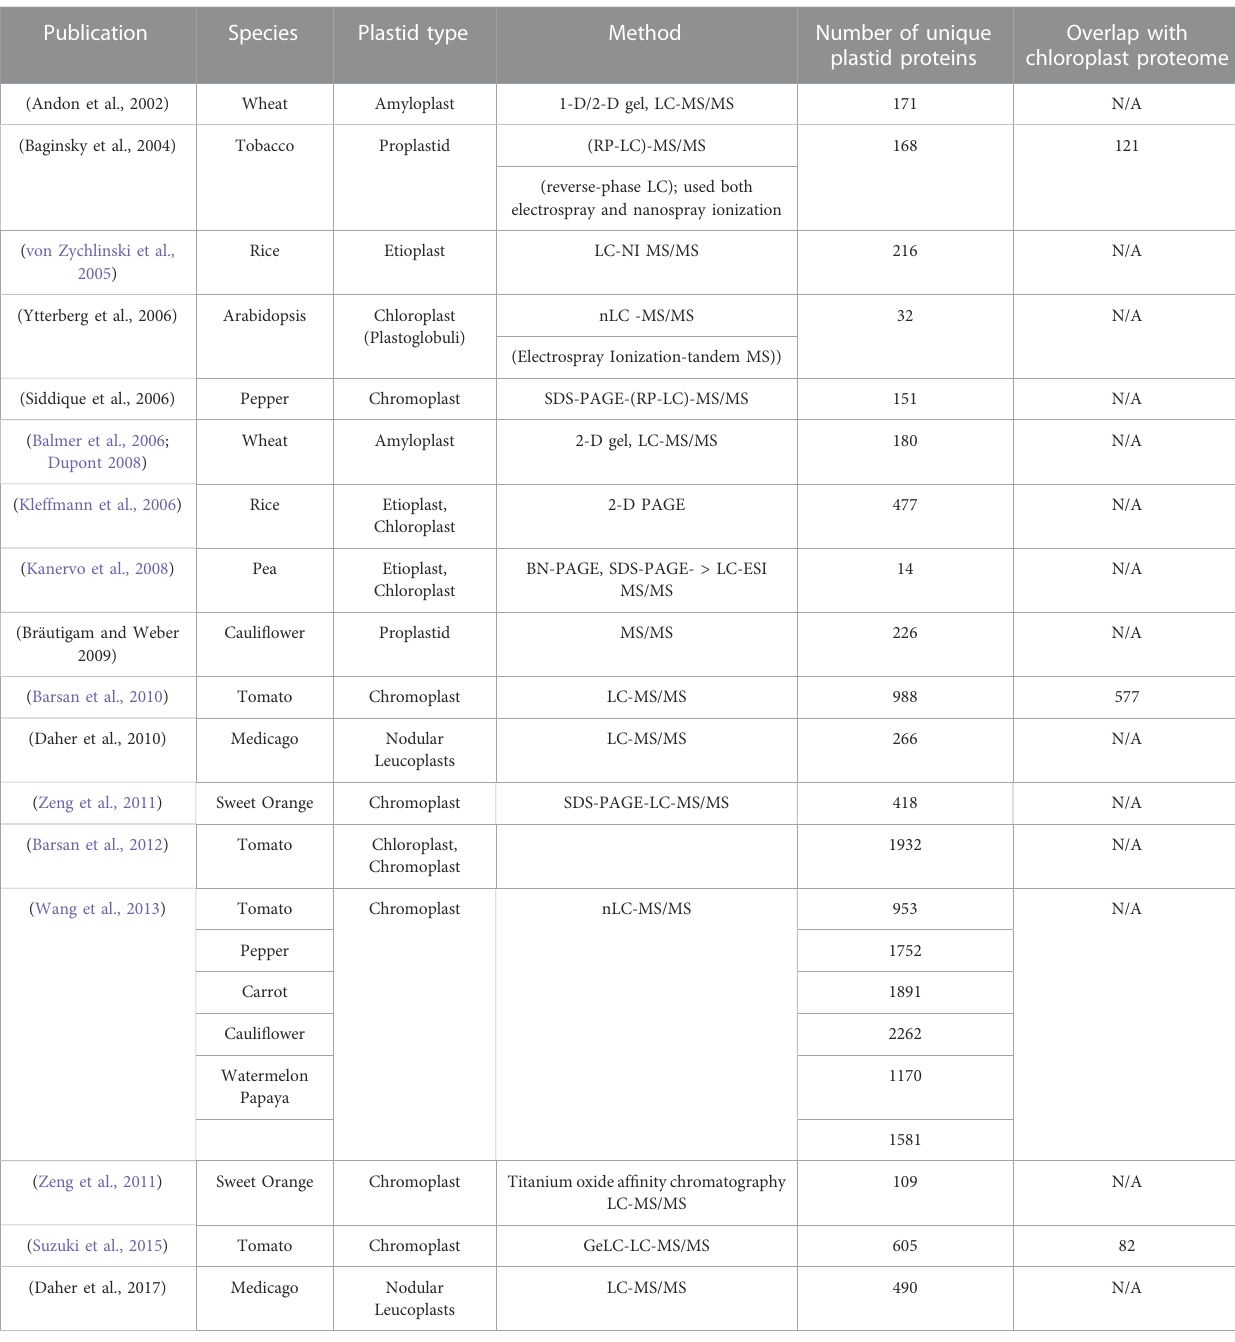
TABLE2SummaryofNon-GreenPlastidProteomicsStudies.Characterizationofnon-greenplastidsarerepresentedbyonlyahandfulofstudies.However,several of the listed publications have found unique proteins in non-green morphotypes that are not present in green chloroplasts. Arabidopsis: Arabidopsis thaliana ; Cauli fl ower: Brassica oleracea ; sweet orange: Citrus sinensis ; carrot: Daucus carota ; kumquat: Fortunella margarita; medicago: Medicago truncatula ; papaya: